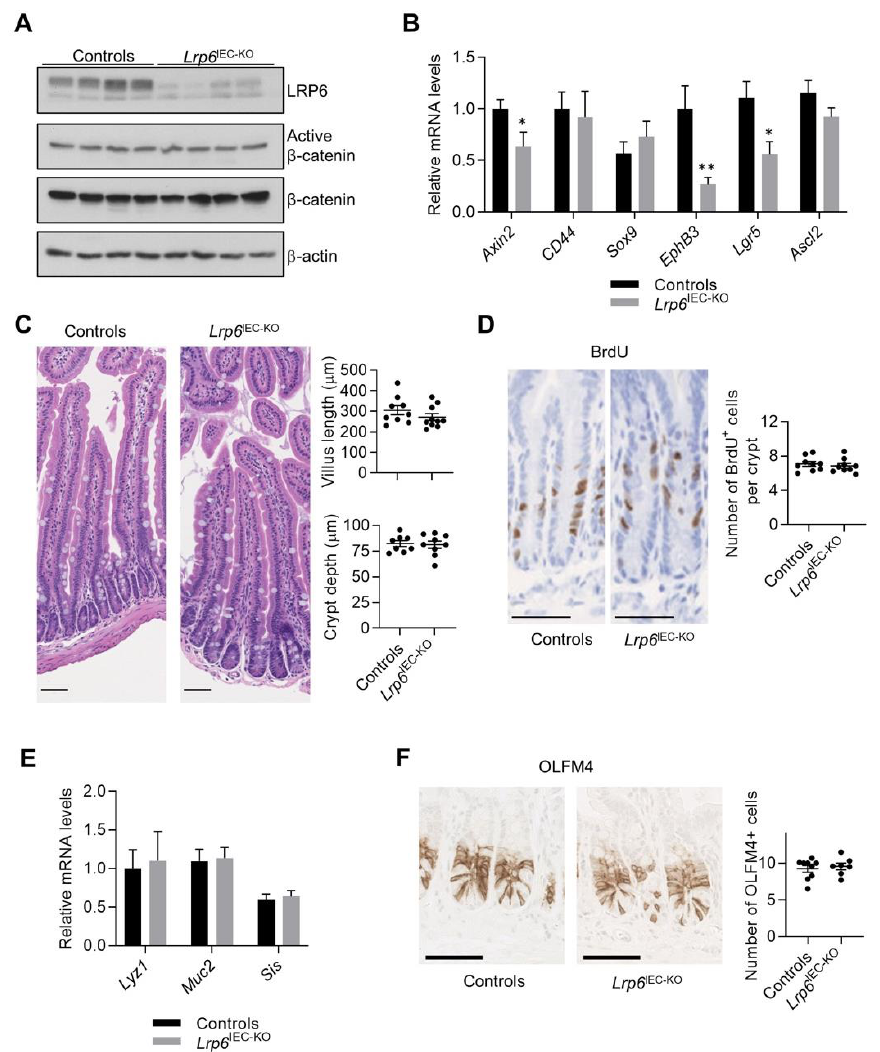
Figure 1. Loss of LRP6 expression affects Wnt target gene expression without altering intestinal architecture. ( A ) LRP6 and β -catenin expression was analyzed in 12-week-old murine small IEC-enriched lysates by Western blot. ( B ) β-catenin target gene expression was evaluated by qPCR of IEC-enriched RNA ( n ≥ 5). ( C ) Villus length and crypt depth were determined on H&E-stained jejunal sections ( n ≥ 8). Bars: 100 µ m. ( D ) Proliferation was assessed after BrdU immunohistochemistry on mutant and control jejunal sections ( n = 9). Bars: 50 µm. ( E ) The expression of mucin 2 ( Muc2 ), lysozyme ( Lyz1 ) and sucrase-isomaltase ( Sis ), the main markers of goblet, Paneth and absorptive cells, respectively, was evaluated by qPCR on IEC-enriched RNA ( n ≥ 8). ( F ) OLFM4 immunohistochemistry was performed on 12-week-old control and Lrp6 I EC-KO jejunal sections ( n ≥ 7) to visualize intestinal stem cells. Bars: 50 µm. Data are expressed as mean ± SEM. Mann–Whitney U test * p ≤ 0.05, ** p ≤ 0.01.